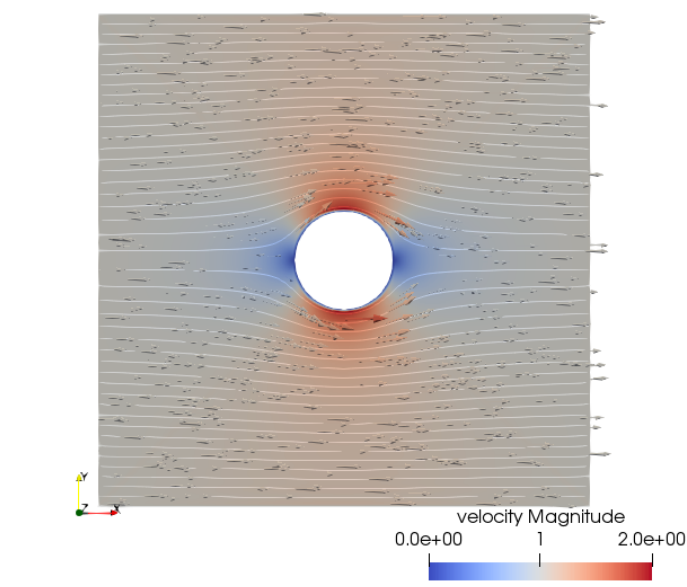
Figure 13. Case 1: the velocity representation with stream lines for domain h 2